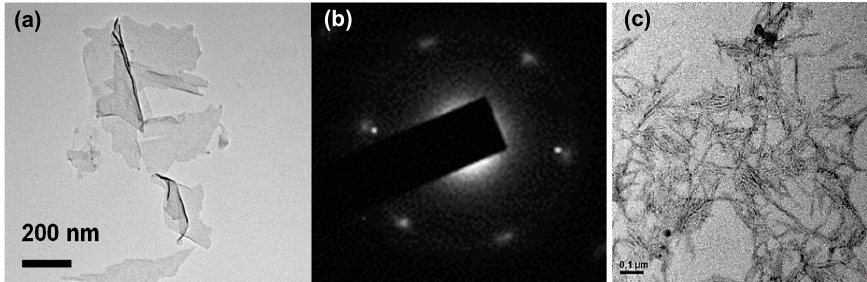
Figure 1. ( a ) TEM images and ( b ) selected area electron diffraction (SAED) patterns corresponded to graphene oxide (GO) nanosheets; ( c ) TEM image of a cellulose nanocrystalline (CNC).